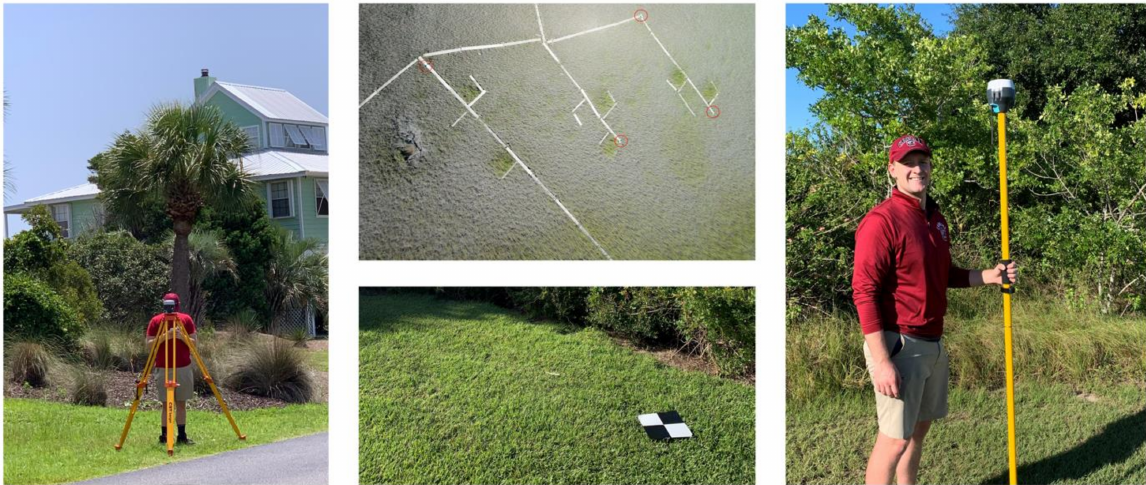
Figure 3. Emlid Reach GNSS base station ( left ) and rover ( right ) for collection of GCPs. ( Top middle ) image shows GCPs placed on the narrow boardwalk in various locations marked with red circles. ( Bottom middle ) image shows a black and white checkerboard